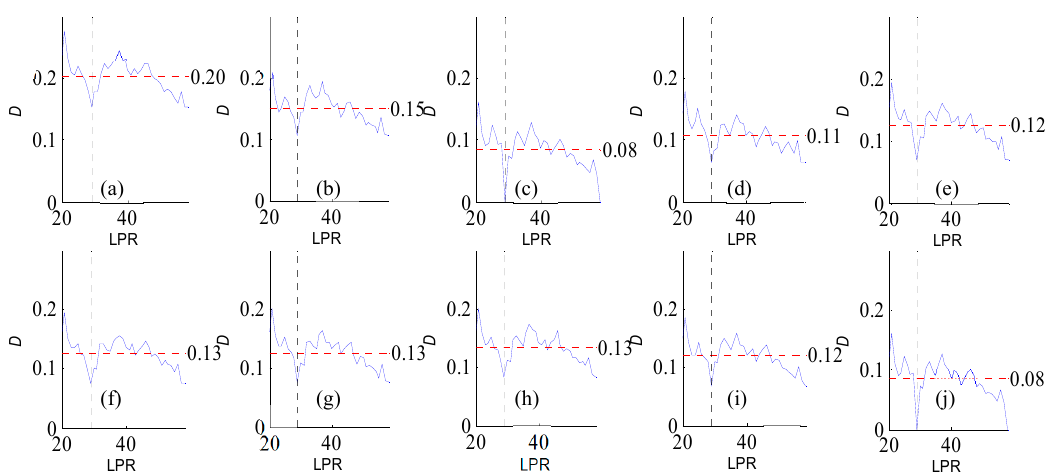
Figure A8. Variation of flow regime alteration degree (D) measured by the RVA with change in the length of post-impact flow time series (LPR) under a periodicity of 28 years. ( a ), ( b ), ( c ), ( d ), ( e ), ( f ), ( g ), ( h ), ( i ), and ( j ) correspond to pre-impact flow time series length = 20, 24, 28, 32, 36, 40, 44, 48, 52, and 56 years, respectively. The abscissa value for the vertical dotted line is 28. The ordinate value for the horizontal dotted line is the mean degree of flow regime alteration in each subfigure.